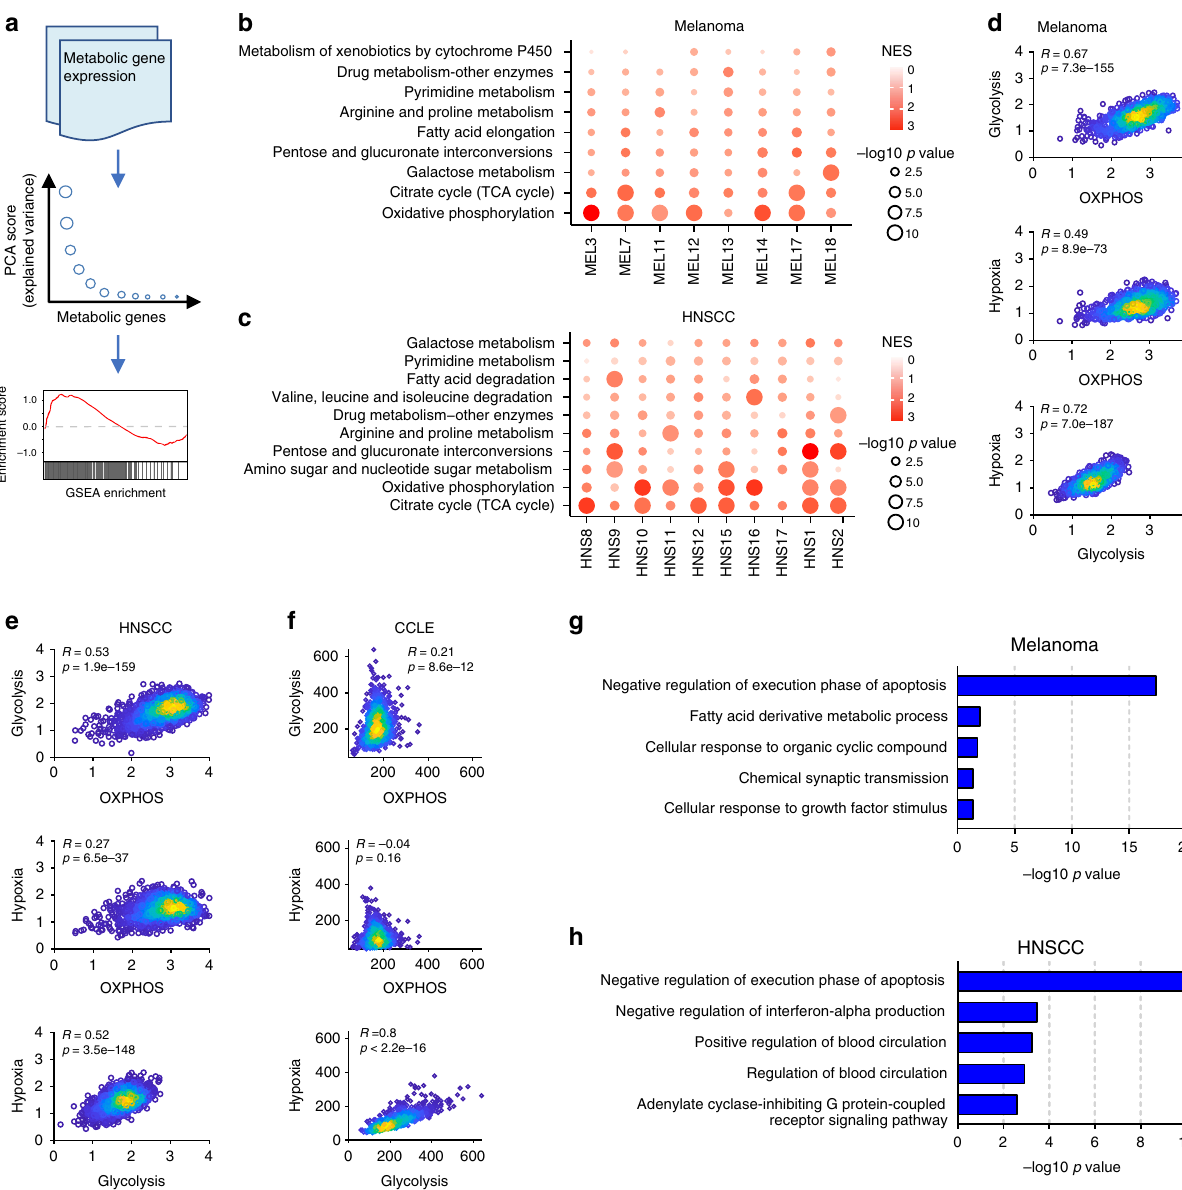
Fig. 3 Intratumoral metabolic heterogeneity of malignant cells. a Work fl ow for quantitating metabolic heterogeneity of malignant cells. b Metabolic pathways enriched in genes with highest contribution to the metabolic heterogeneities among malignant cells from different tumors in the melanoma dataset. c Same as in b but for the HNSCC dataset. d Scatter plots comparing activities of glycolysis, OXPHOS and response to hypoxia in single malignant cells from the melanoma dataset. Colors of points indicate local density of points. e Same as in d but for the HNSCC dataset. f Same as in d but for cancer cell lines from CCLE. g GO terms enriched in genes up-regulated in cells with lowest expression levels of glycolysis, OXPHOS and hypoxia pathways in the melanoma dataset. h Same as in g but for the HNSCC